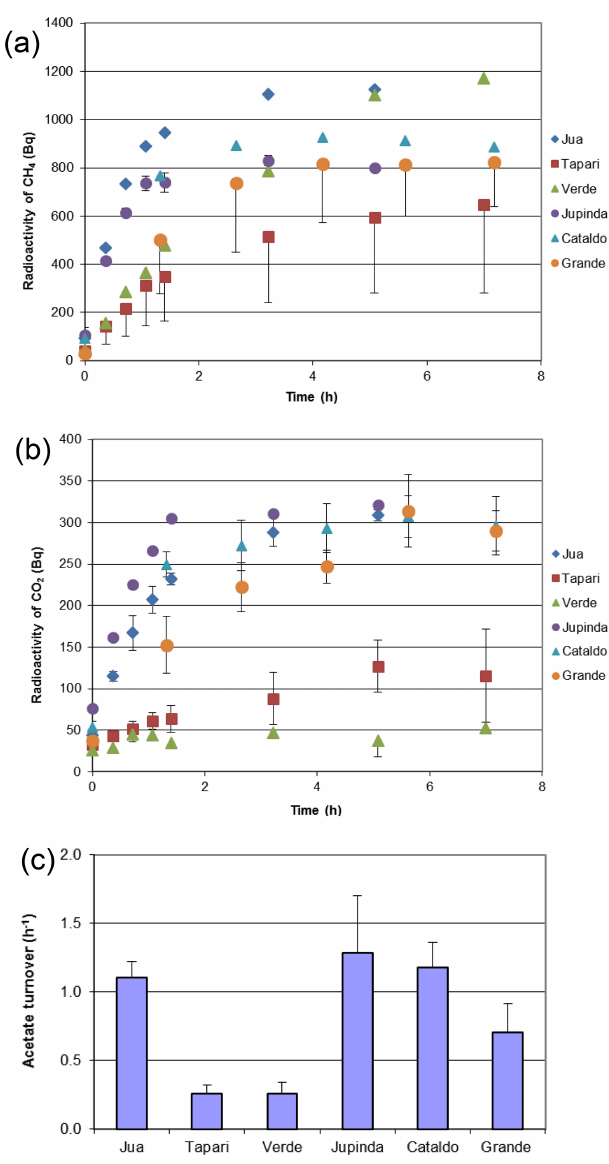
Figure 3. Conversion of 2- 14 Cacetate in sediments of different Amazonian lakes: (a) accumulation of radioactive CH 4 , (b) accu- mulation of radioactive gaseous CO 2 and (c) acetate turnover rate constants (mean ± SE).